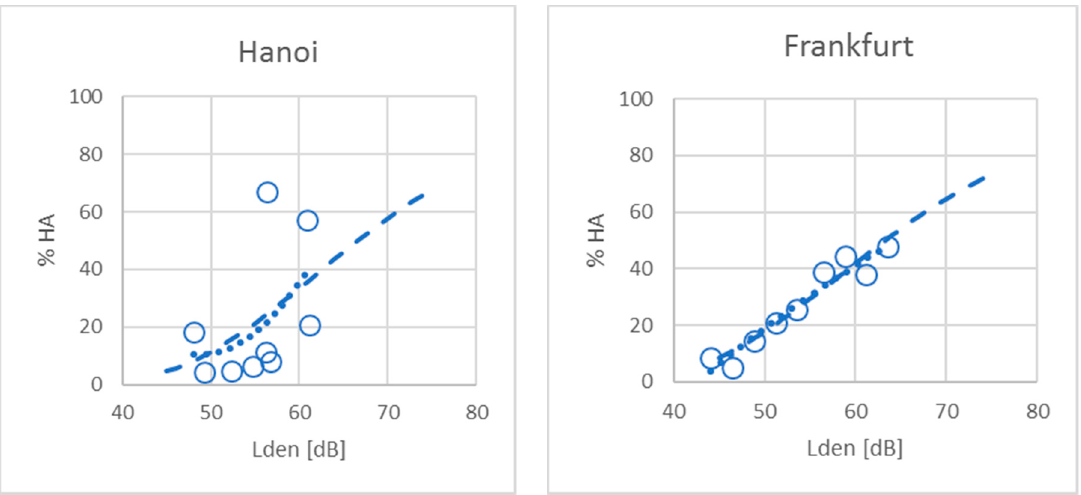
Figure 1. Survey data from individual airports with corresponding CTL curve (dashed) and 2nd order polynomial regression function (dotted). Table 1. Coefficient of determination for CTL curves and statistical regression functions Airport